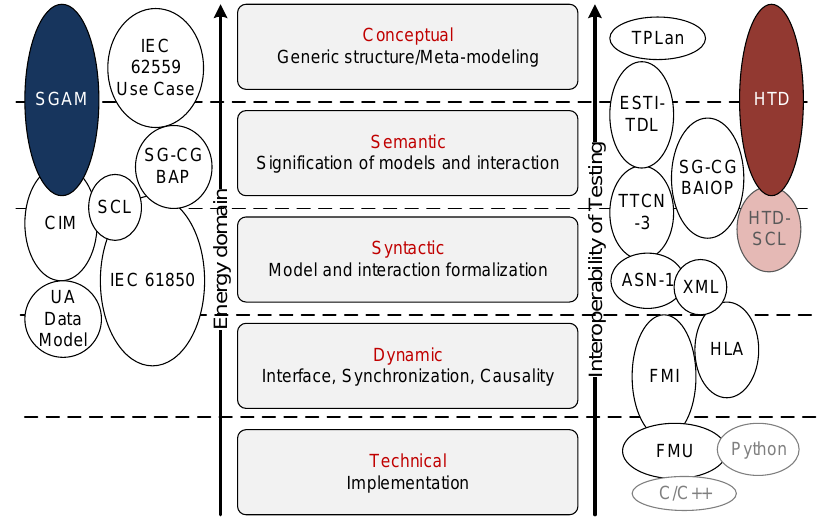
Figure 2. Abstraction layers of a holistic test and the related